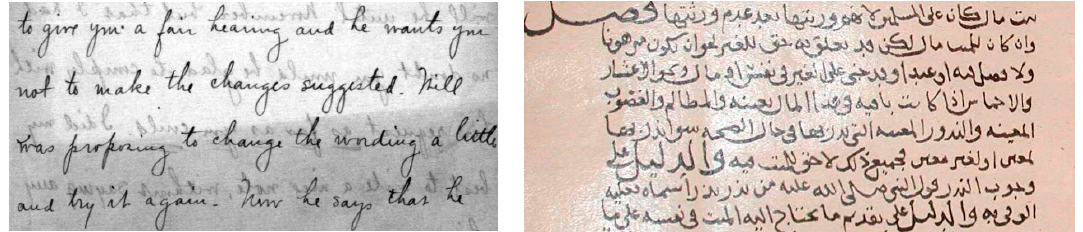
Figure 3. Uneven illumination in historical handwritten document from DIBCO (left) and Arabic Databases (right).